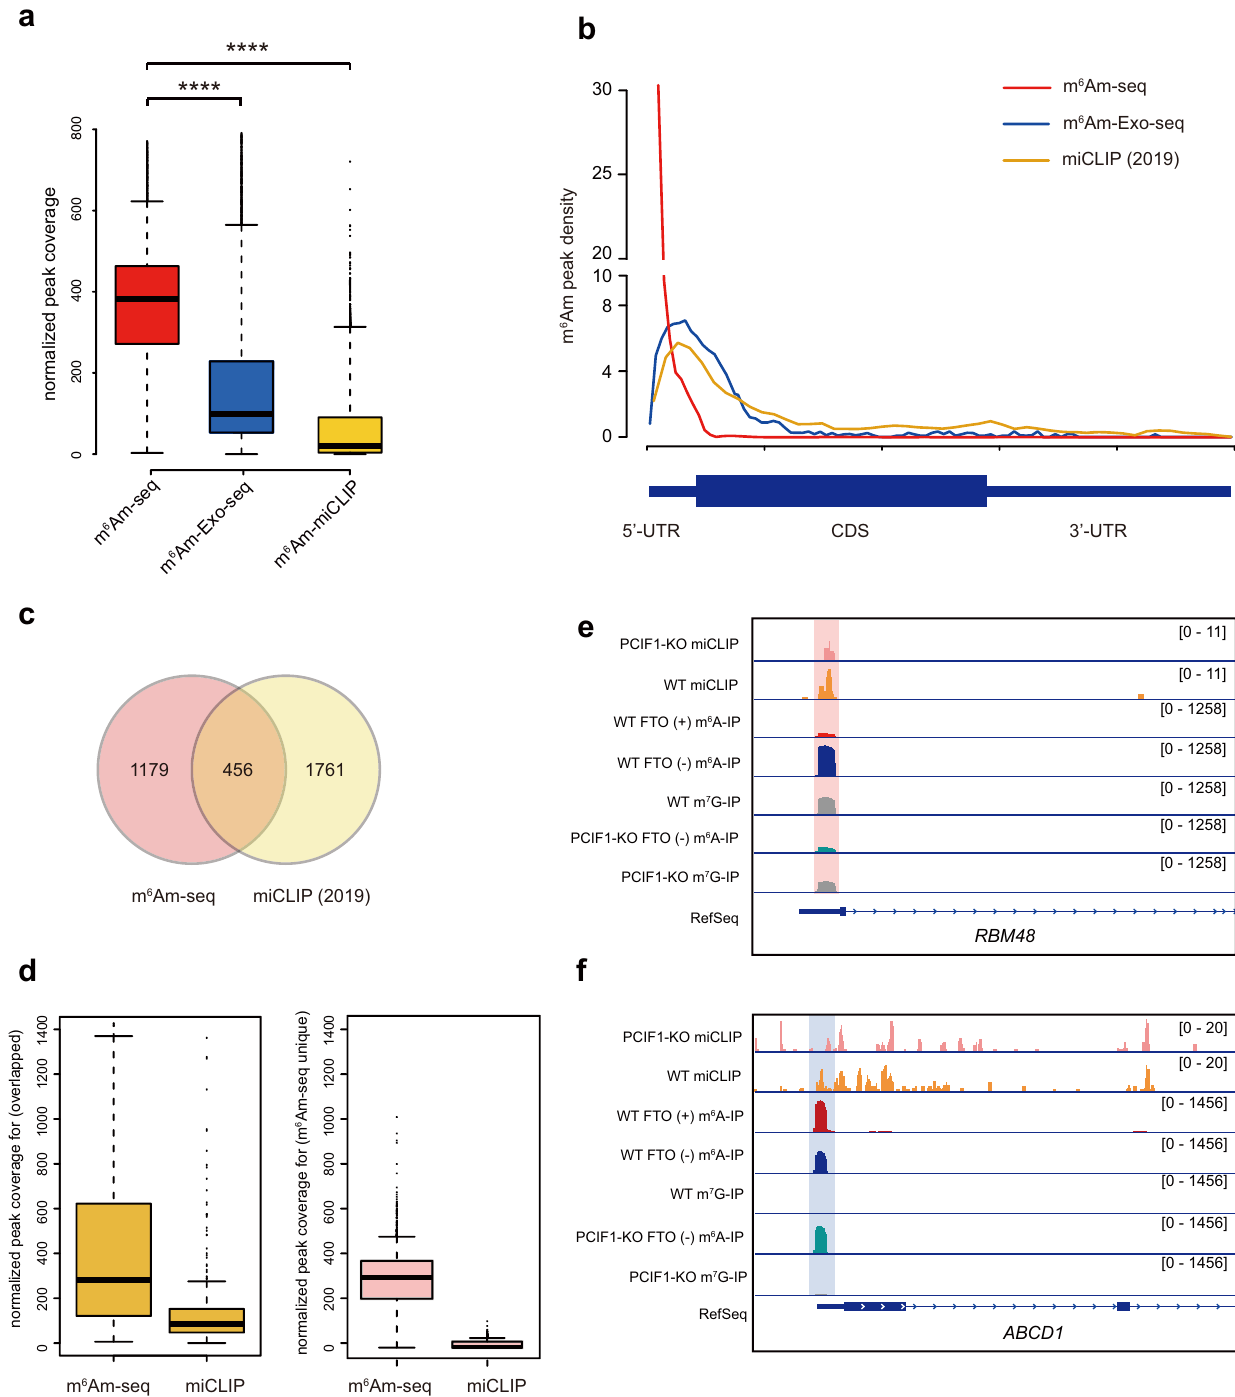
Fig. 3 Comparison of m 6 Am methylome detected by m 6 Am-seq and existing m 6 Am detection methods. a Boxplot showing that the normalized peak coverage by m 6 Am-seq (red, n = 1652), m 6 Am-Exo-seq (blue, n = 3169), and miCLIP (yellow, n = 2217). Statistical signi fi cance of the difference was determined by unpaired two-sided Mann – Whitney U -test. **** P < 2.2e − 16 for m 6 Am-seq vs m 6 Am-Exo-seq, m 6 Am-seq vs miCLIP. Boxes represent 25th – 75th percentile (line at the median) with whiskers at 1.5*IQR. b Metagene pro fi les of m 6 Am distribution identi fi ed by the three sequencing methods. Each segment was normalized according to its average length in RefSeq annotation. c Venn diagram showing the overlap of m 6 Am-marked genes by m 6 Am-seq and by miCLIP. d Boxplot showing the normalized peak coverage of shared m 6 Am peaks (yellow, n = 456, identi fi ed in both m 6 Am-seq and miCLIP) and m 6 Am-seq-unique m 6 Am peaks (pink, n = 1179) in the m 6 Am-seq and miCLIP data sets, respectively. Boxes represent 25th – 75th percentile (line at the median) with whiskers at 1.5*IQR. e An example of m 6 Am (in the RBM48 gene), which was missed by miCLIP due to its limited sensitivity but is clearly identi fi ed by m 6 Am-seq. The m 6 Am peak is lost in PCIF1-KO data sets, further proving the detection con fi dence of m 6 Am-seq. Pink background color denotes m 6 Am signal. f An example of mis-annotated m 6 Am (in the ABCD1 gene) by miCLIP. This peak is not affected by FTO treatment nor PCIF1- KO, showing that it is a 5 ′ -UTR m 6 A modi fi cation. Blue background color denotes m 6 A signal. Source data are provided as a Source Data fi